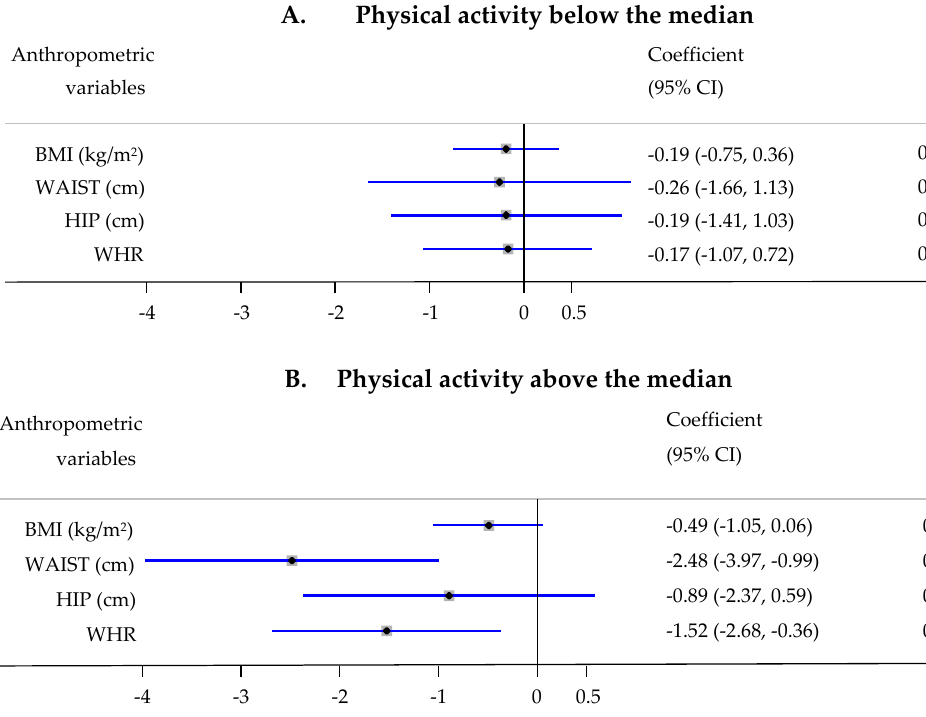
Figure 1. Association of Alternative Mediterranean Diet (aMED) score tertiles with anthropometric measurements stratified by physical activity—increase or decrease in 1 unit in anthropometric measurements (0.01 unit for WHR) per 1-tertile increase in the score, adjusted for age, center, education, and energy intake. A. Physical activity below the median; B. Physical activity above the median.